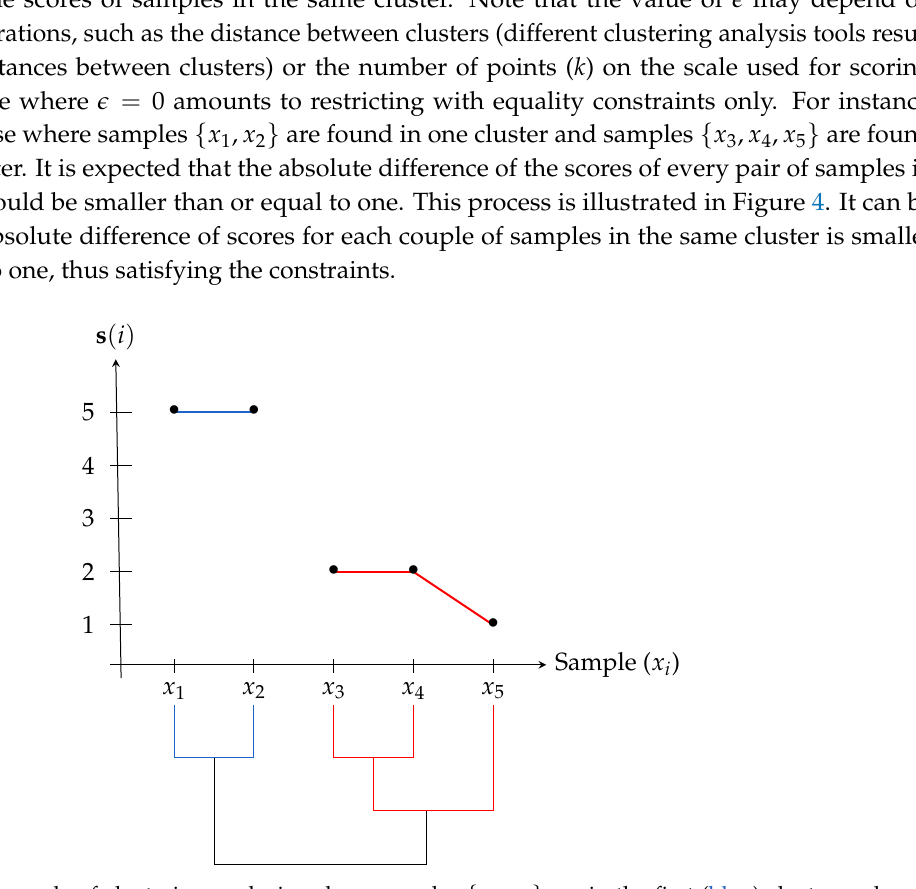
Figure 4. Example of clustering analysis, where samples { x 1 , x 2 } are in the first (blue) cluster and samples { x 3 , x 4 , x 5 } are in the second (red) cluster. The scores are consistent with the clusters or, equivalently, satisfy the